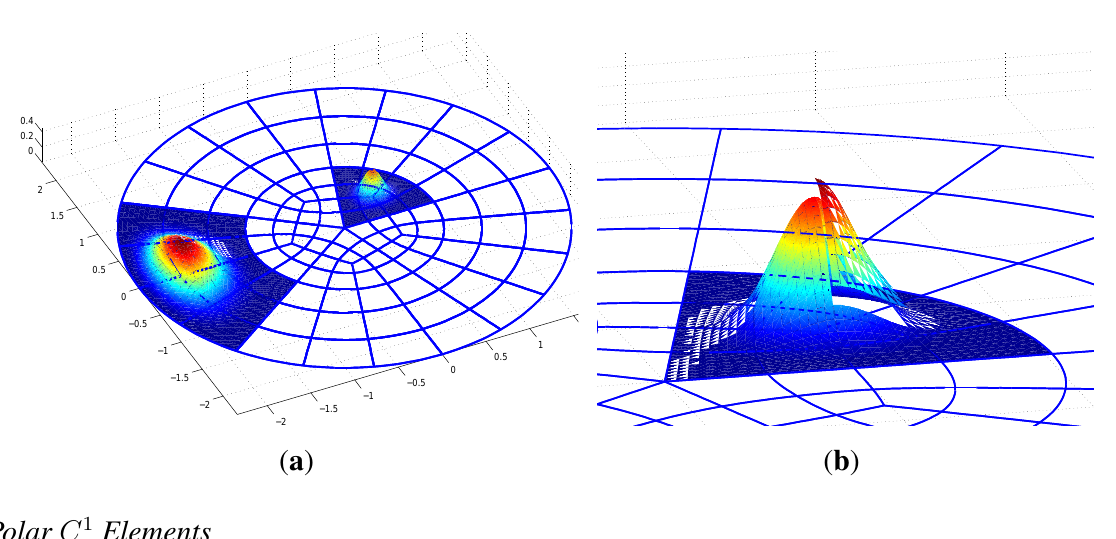
Figure 7. G 1 element at an extraordinary point. ( a ) Two G 1 bi-3/bi-5 basis functions; ( b ) G 1 bi-3/bi-5 basis function with onepatch in BB-form lifted